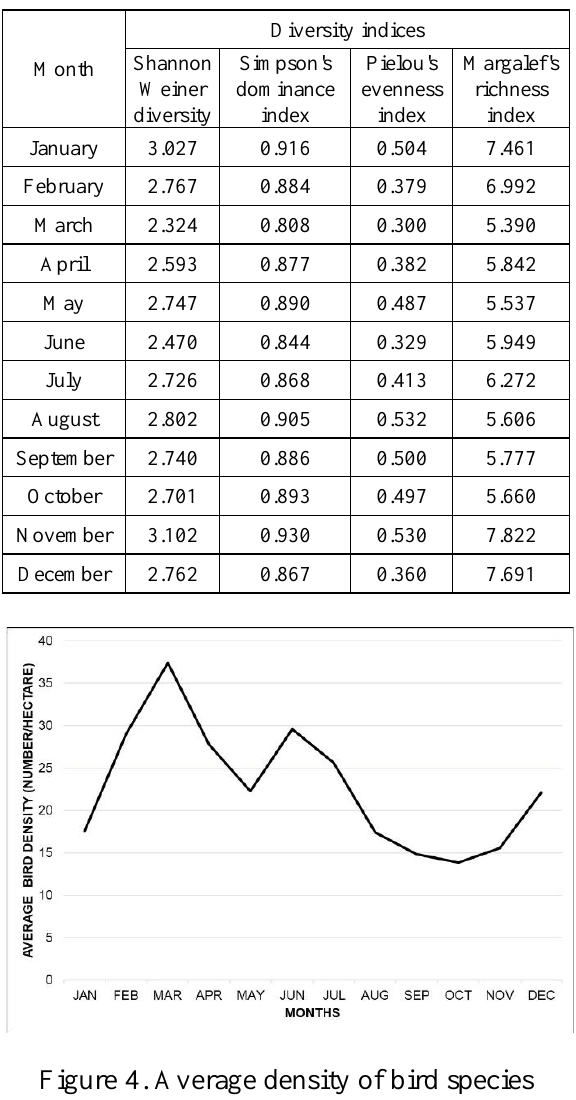
Table 2. Different diversity indices of bird species in Durgapur Government College Campus covering all the seasons